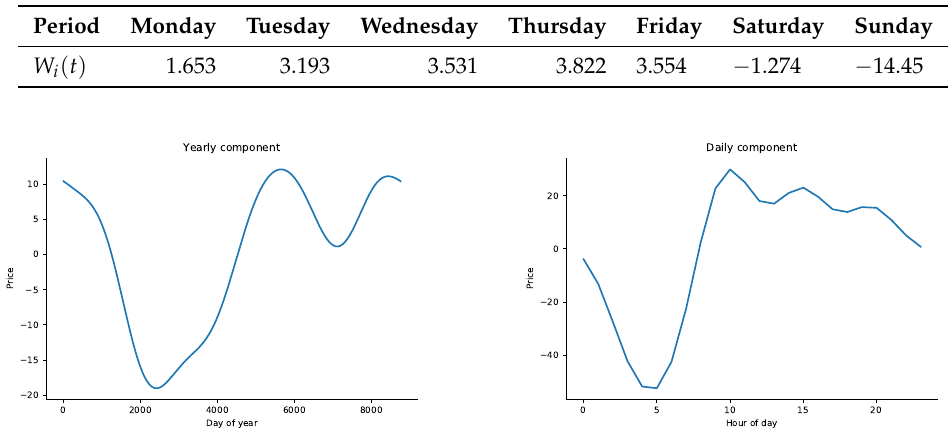
Table 3. Weekly components.